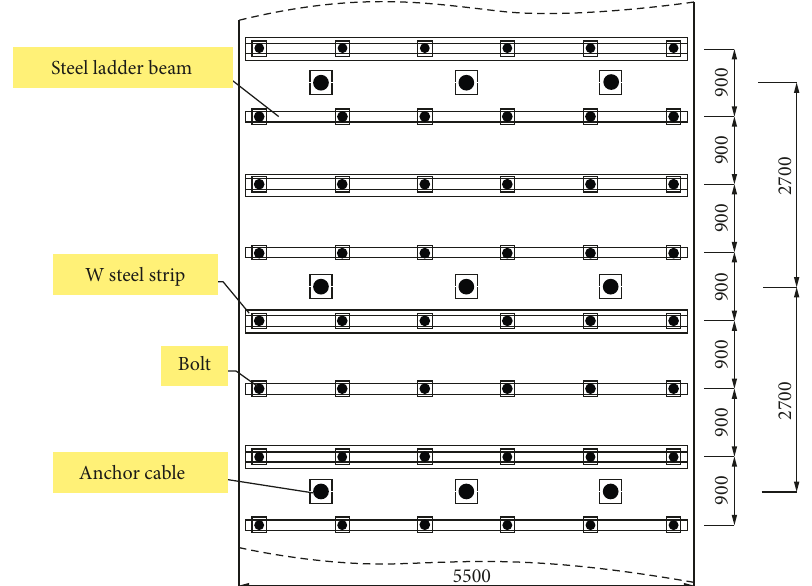
Figure 15: Schematic diagram of retracement laneway roof support.